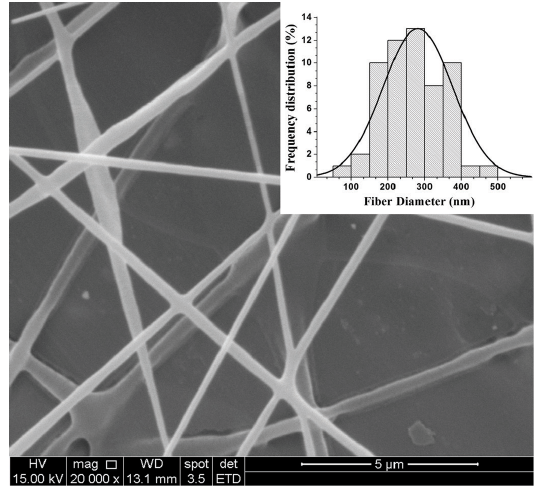
Figure 1. SEM micrograph of electrospun PHB nanofibers mat. (Magnification 20,000 X).